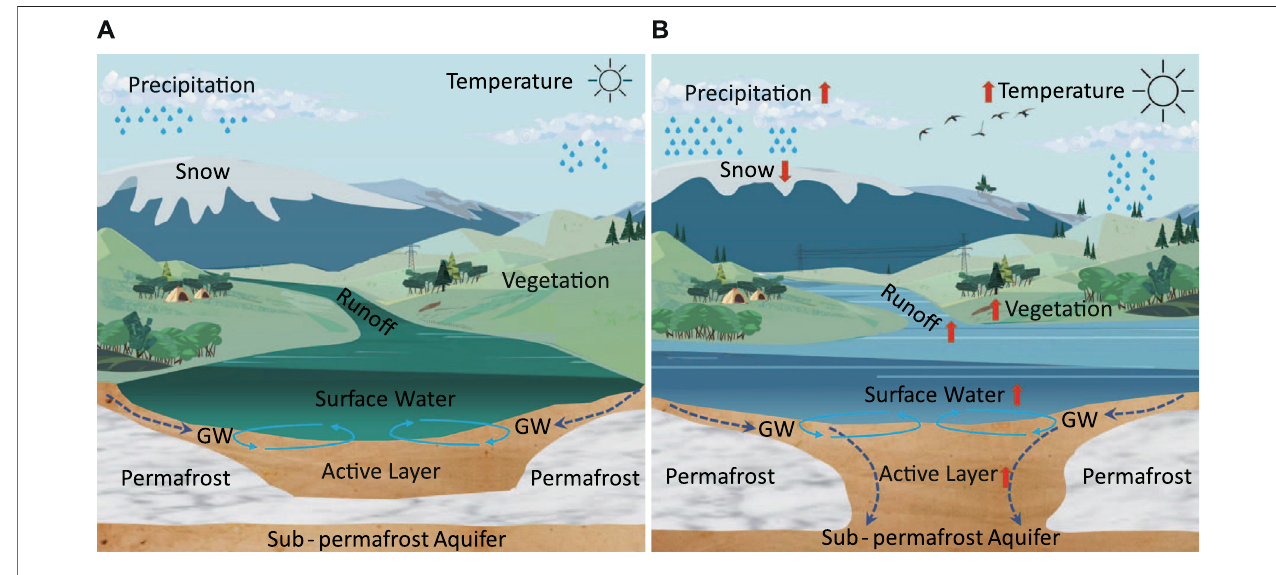
FIGURE 1 | Cold region GW-SW interactions before (A) and after (B) climate change.